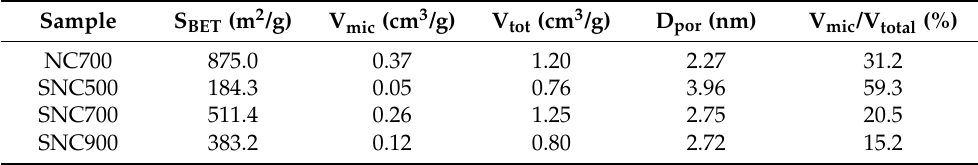
Table 2. Comparison table of specific surface area and pore structure properties of carbon materials at different carbonization